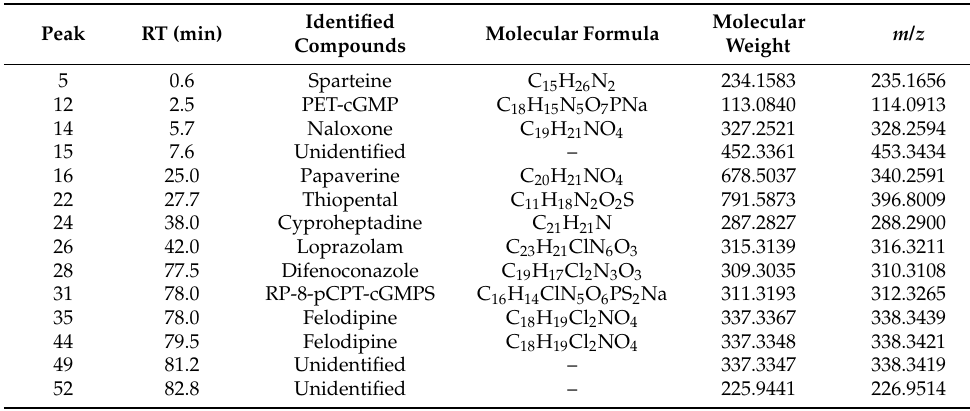
Figure 2. LC-MS/MS chromatogram of B. tuldoides . Table 6. The compounds identified in B. tuldoides .